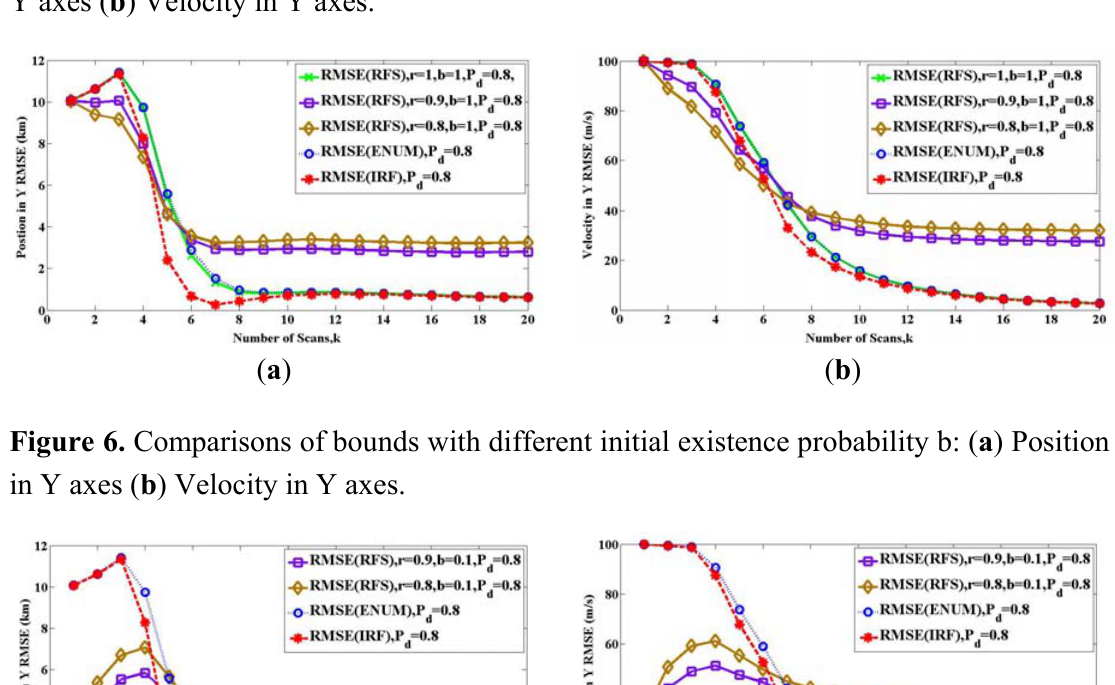
Figure 5. Comparisons of bounds with different maintenance probability r: ( a ) Position in Y axes ( b ) Velocity in Y axes.